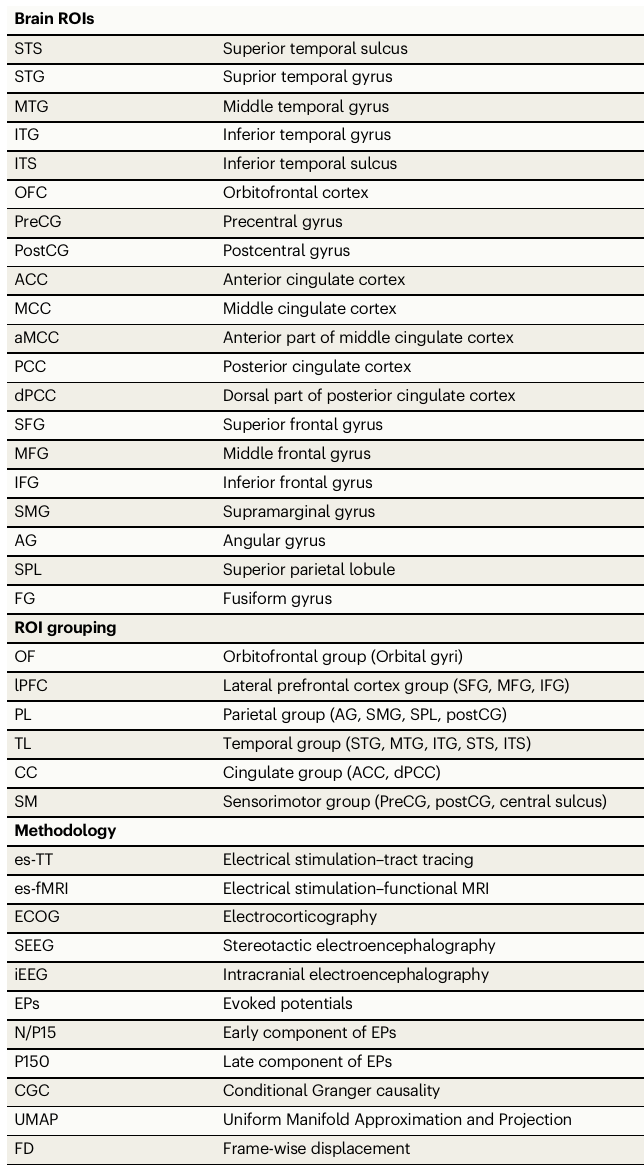
in the later time window de fi ning P150 potential. e Same as panel ( c ), but for P150 component. Two-sided t -tests. f Decoding accuracy for stimulation site (medial- vs lateral-group amygdala stimulation). Horizontal axis indicates the input feature dimension. Here the input features were from EPs quanti fi cation process (see “ Methods ” ). Range means the EPs range values (see panels b and d and “ Methods ” ). Error bars indicate mean (center of error bars) and SE from 10-fold cross validation. Black and red line indicates classi fi cation accuracy from original and shuf fl ed datasets, respectively. g Decoding accuracy of medial- and lateral-group amygdala stimulation performed on the EPs wave- form. Time dimension was nonlinearly reduced with UMAP. Horizontal axis indicates the UMAP dimension used. Error bars and line-color indicate the same as in ( f ). Green line indicates classi fi cation accuracy of the original dataset but with ROI is also used as an input features. For the creation of brain backgrounds in panels ( b ) – ( e ), we used Conte69.32k surface mesh 103 obtained from https://biomedia.doc.ic.ac.uk/brain-parcellationsurvey/) under WU- Minn HCP Consortium Open Access Data Use